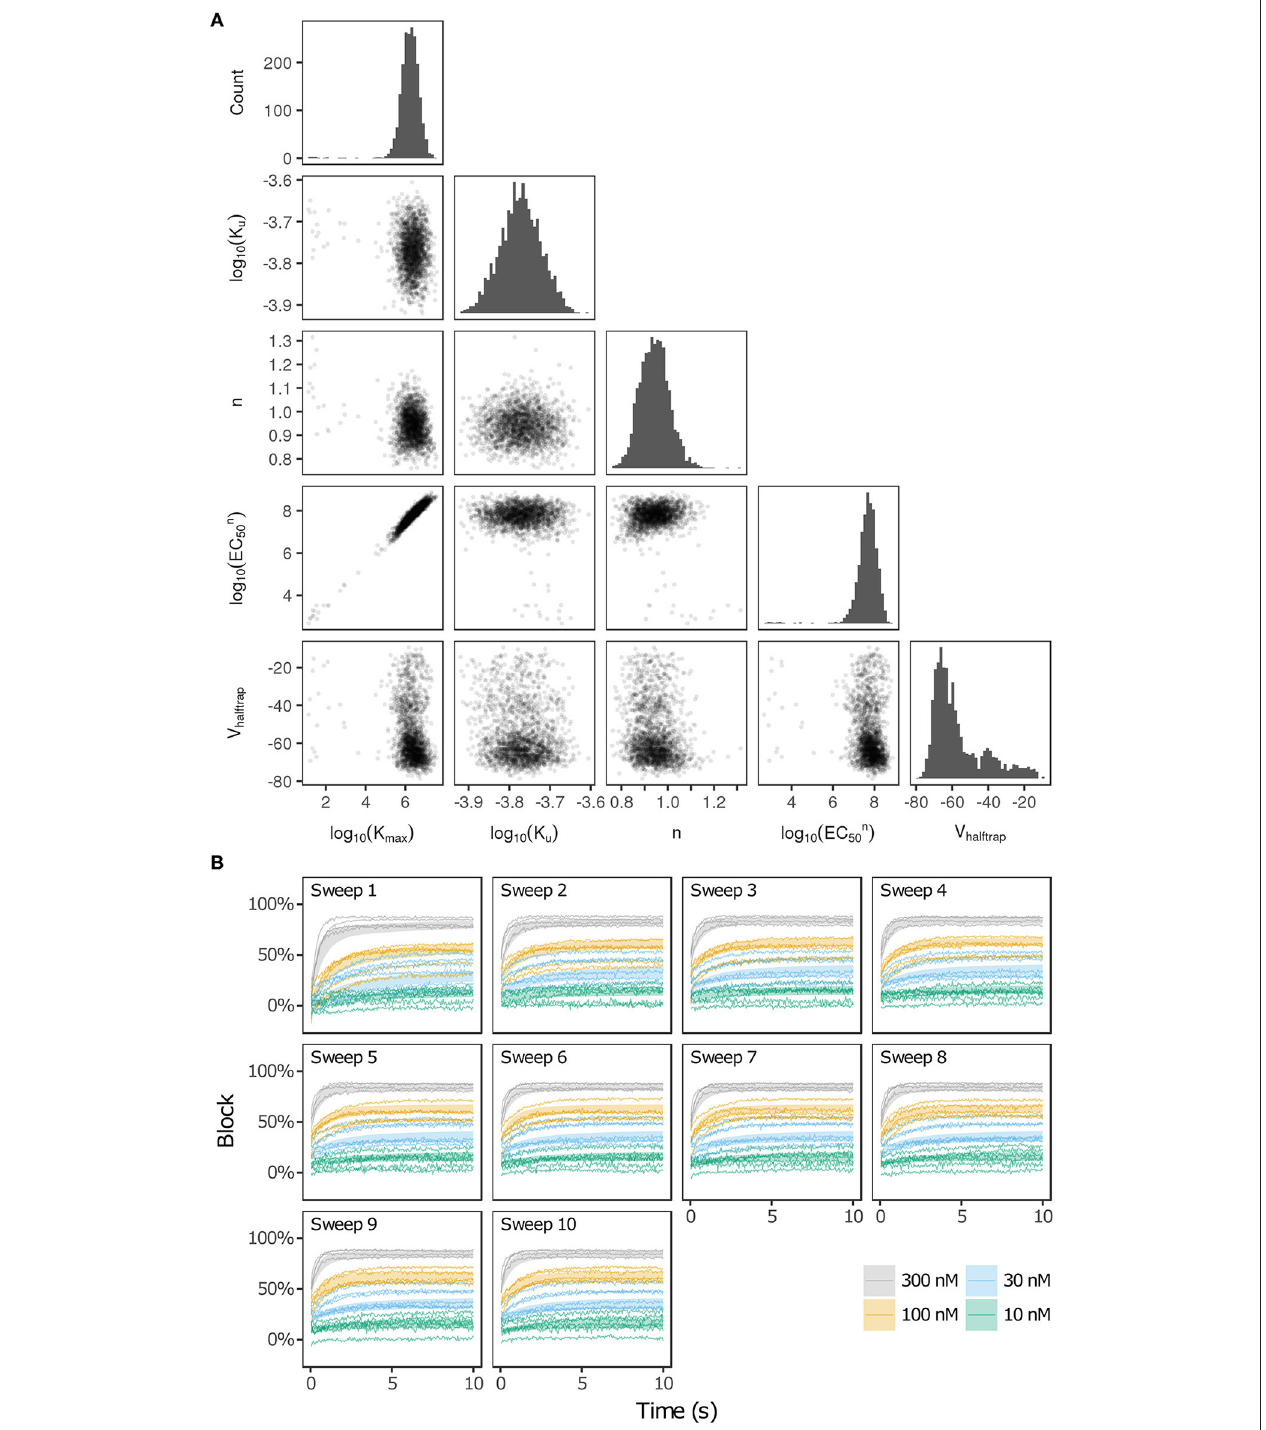
FIGURE 1 | Uncertainty in bepridil-hERG binding kinetics. (A) The joint probability distribution of K max (maximum drug effect at saturating concentrations), K u (rate of drug unbinding), n (Hill coefficient of drug binding), EC 50n (nth power of the half-maximal drug concentration), and V halftrap (drug trapping potential) was estimated by bootstrapping. Plots on the diagonal show the marginal histograms of each parameter (log-transformed in some cases). Plots below the diagonal show pairwise scatter plots of the fitted parameters for 2,000 bootstrap samples. (B) Kinetics of hERG block during 10 sweeps of a modified Milnes voltage-clamp protocol (Milnes et al., 2010; Li et al., 2017). Shaded areas show the range of block produced by the parameters from (A) . Lines show the experimental results used to fit the data (down-sampled 5 × for clarity).